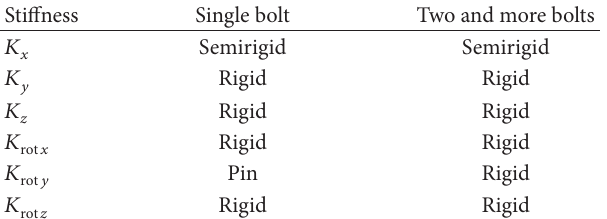
Figure 17: FE simulation of tower 2. Table 3: Joint stiffness models.